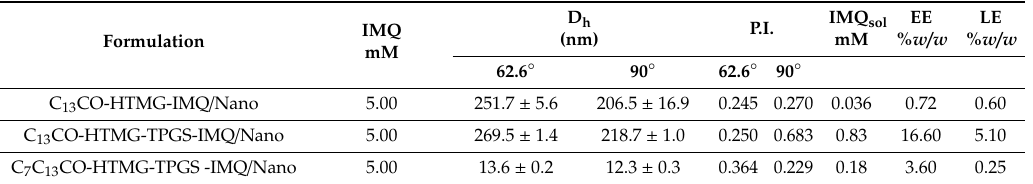
Table 4. Technological characteristics: hydrodynamic diameter (D h ), polydispersity index (P.I.), amount of IMQ solubilized (IMQ sol ), and entrapment and loading e ffi ciency (EE% and LE%). D h IMQ Formulation mM